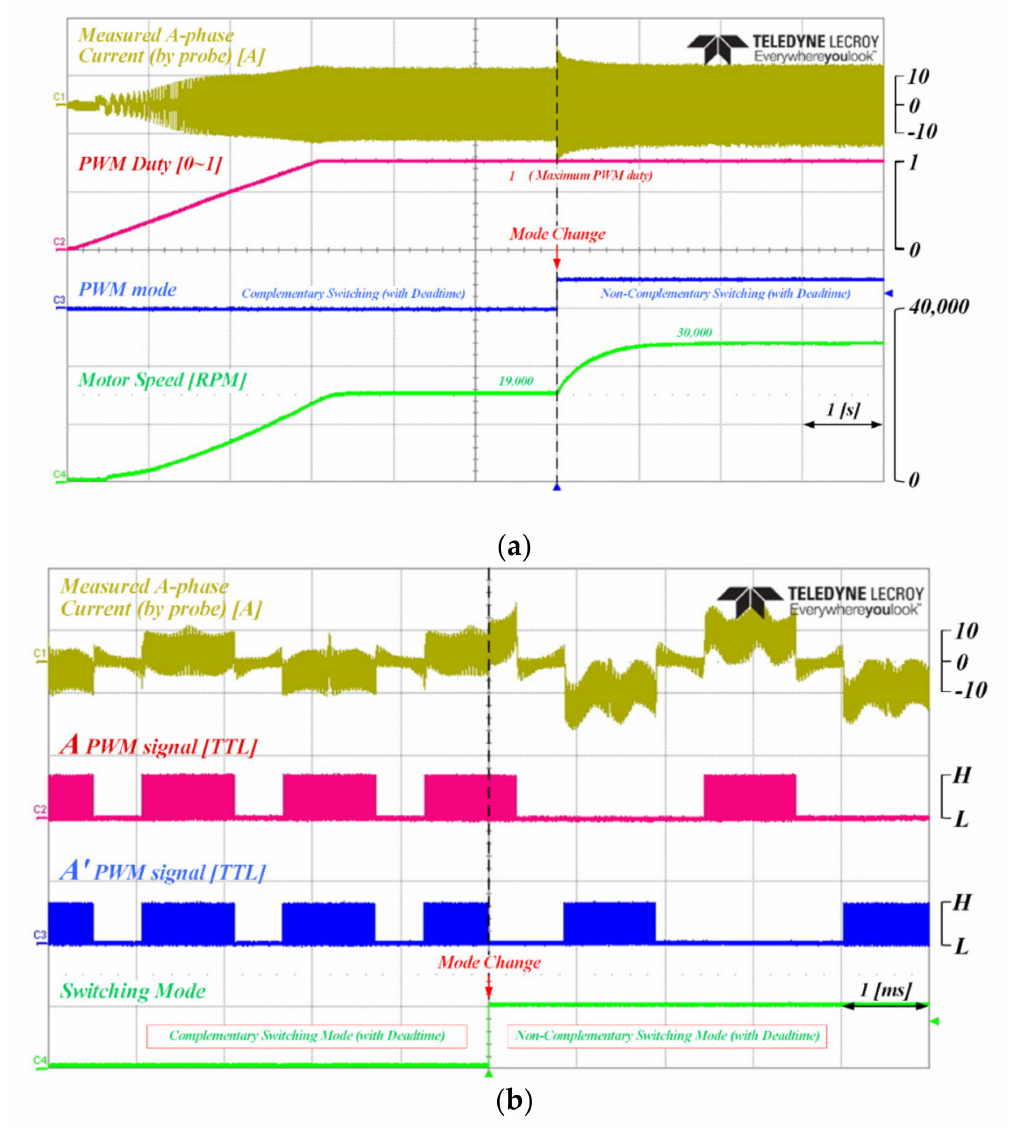
Figure 8. Experimental results of the acceleration operation using the proposed control algorithm (from start to limited speed and expanded speed): ( a ) entire operation region; ( b ) enlarged waveform of the phase current and PWM pattern at the time of switching mode